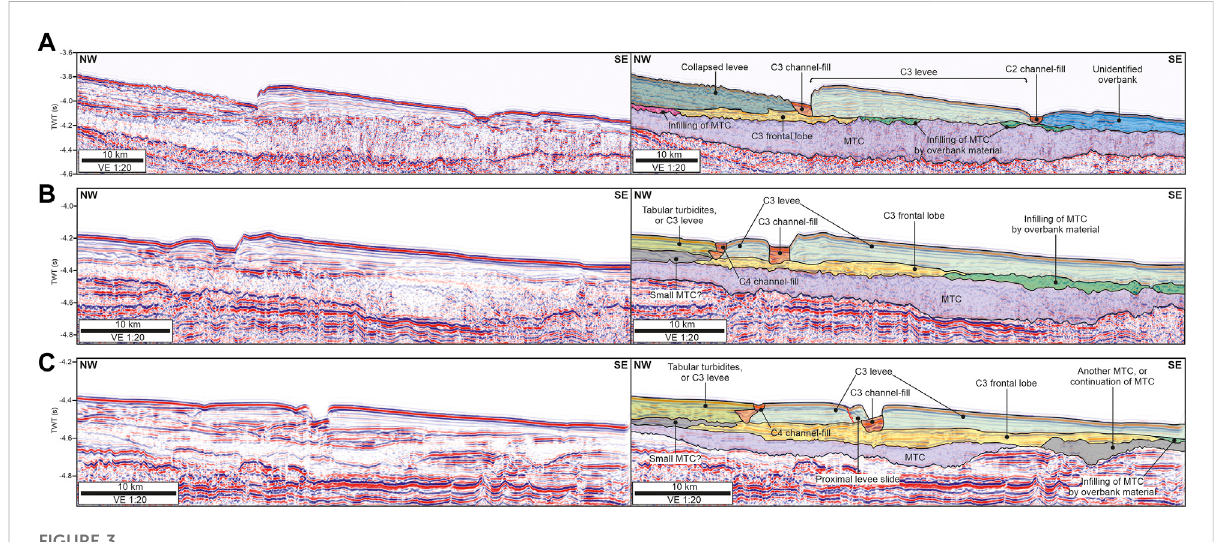
FIGURE 3 2D seismic sections (3A updip, through to 3C downdip) showing temporal evolution and cross-cutting relationships of C2-C4, beginning with mass-transport complex emplacement, followed by frontal lobe deposition. (A) Shows propagation and deposition of C3, with C2 cutting into the right-hand levee of C3. (B) Cross-section taken ~60 kmfurther down dip, showing athicker packageof frontal lobe deposits, overlain by C3,the left leveeofwhichiscutbyC4. (C) (~75 kmdown-dip)showsfurtherthicknessincreasesoffrontallobedeposits,aswellasC4againcuttingintothe left levee of C3. The frontal lobe deposits are linked to channel C3 because only C3 is present in section A, it underlies the C3 channel and levees in sections B and C, and because C2 and C4 are shown to be younger than C3. Channel cross-section locations are shown in Figure